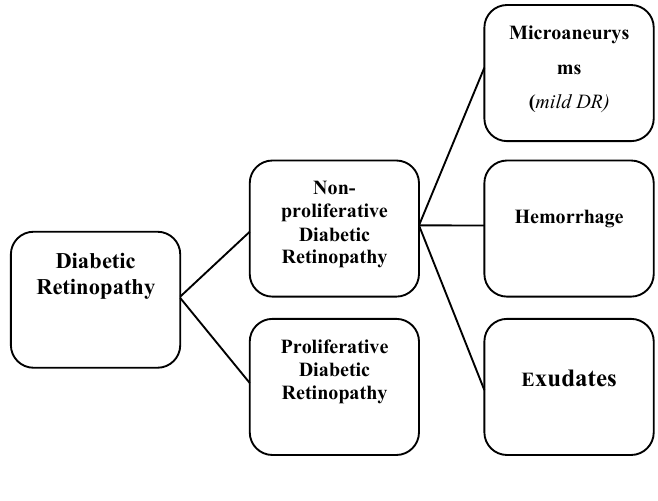
Figure 5. Classification of Diabetic Retinopathy